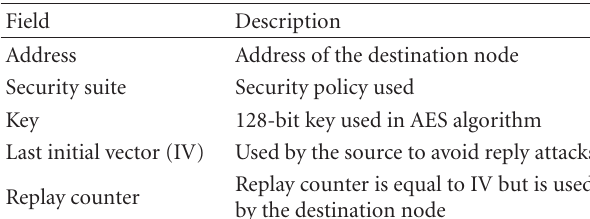
Table 6: Access control list